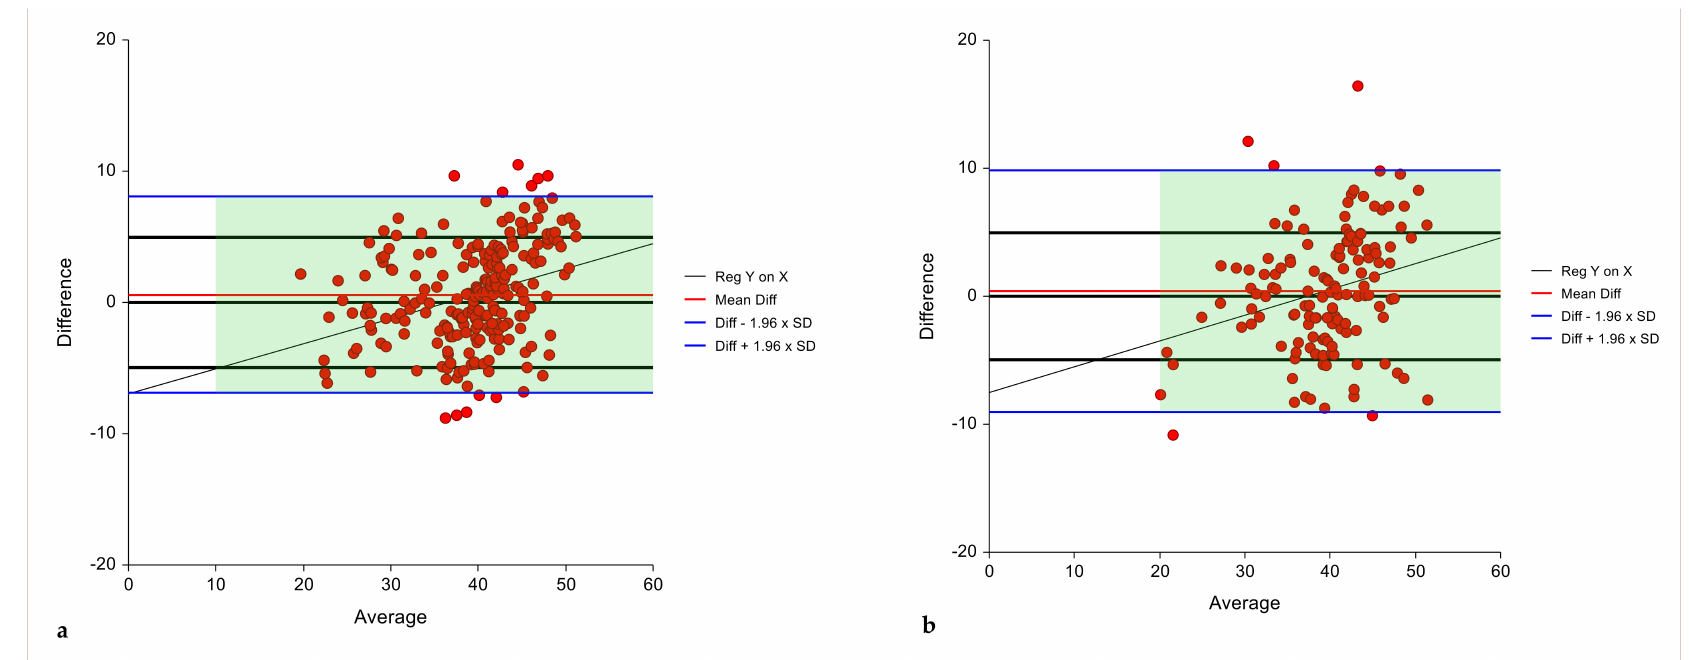
Figure 3. Bland–Altman plot for the agreement between measured and predicted BF% in the ( a ) training sample ( n = 238) ( b ) validation ( n = 137) samples, model